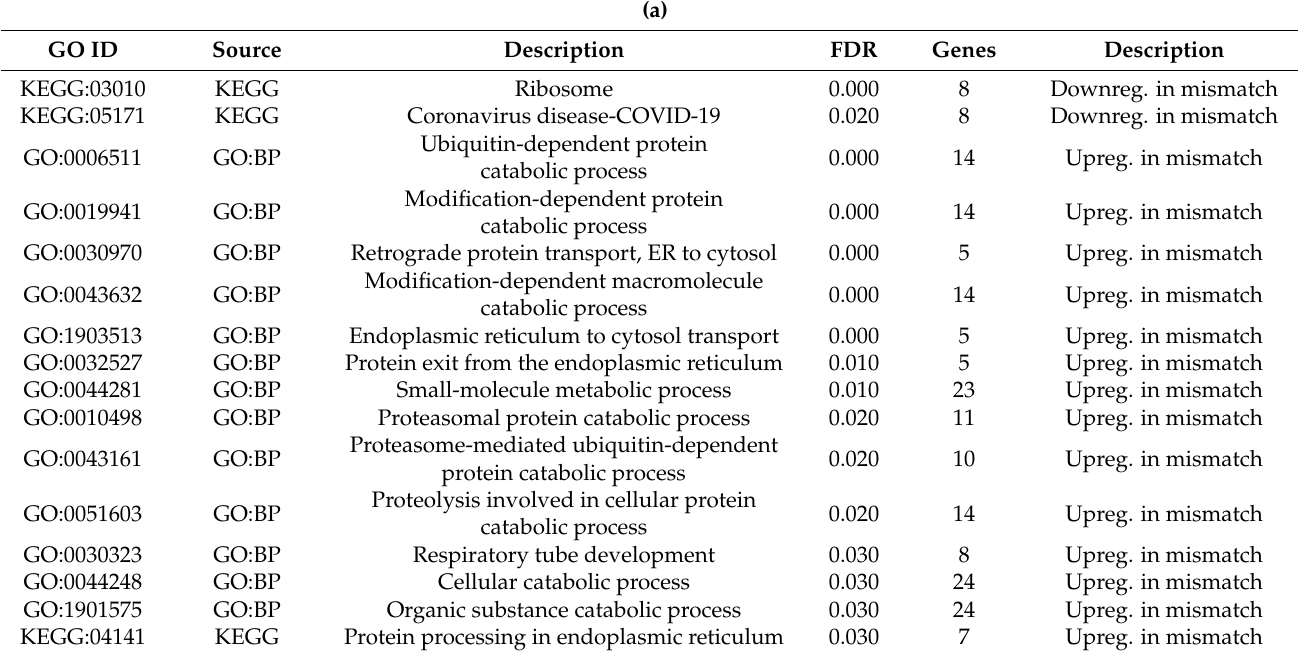
Table 2. Pathway analyses at 4.5 weeks of age describing the interaction effect between piglet diet during the nursery phase and maternal diet during late gestation at an FDR < 0.10. Up- and down-regulated genes were analyzed separately (a) and together (b). (a): pathway analysis for either up- or downregulated genes in the mismatched group. (b): pathway analysis for both up- and downregulated genes